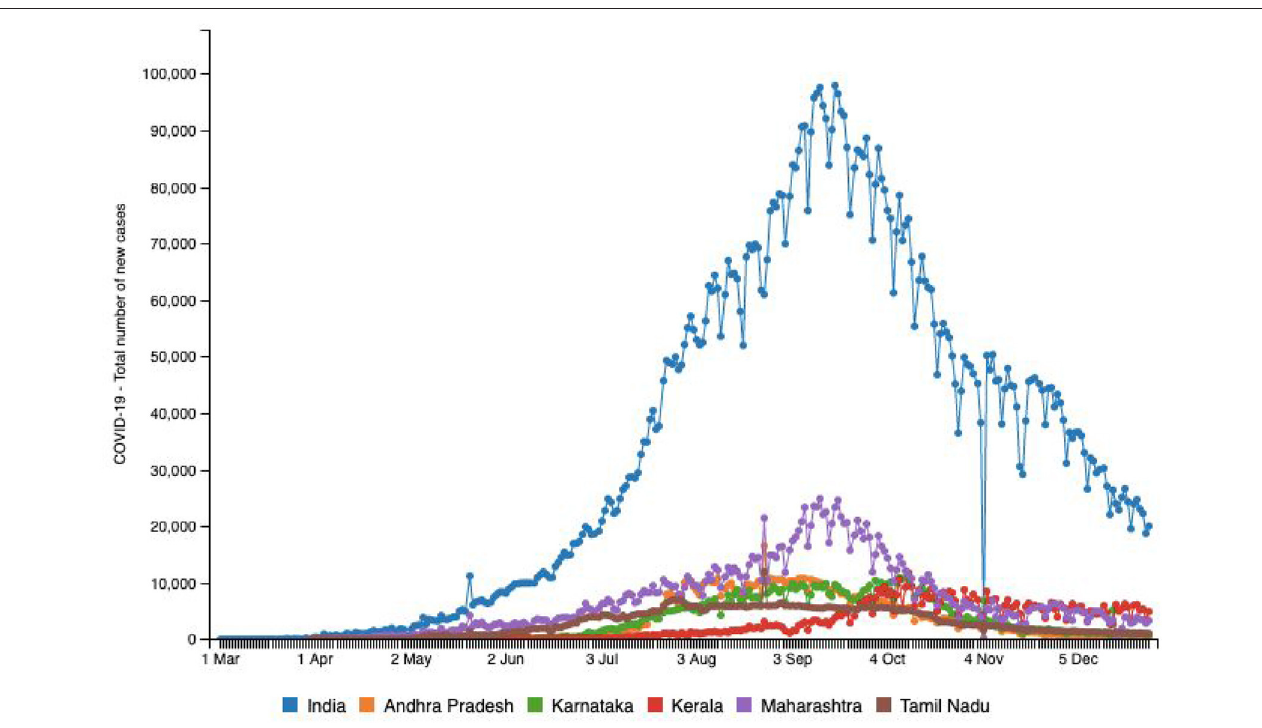
FIGURE 3 | Source: http://www.smaartrapidtracker.org, accessed on December 29, 2020. Status of COVID-19-Total number of new cases in India, and in the states of Maharashtra, Andhra Pradesh, Delhi, Karnataka, Uttar Pradesh, and Tamil Nadu (March 1, 2020 to December 29, 2020).